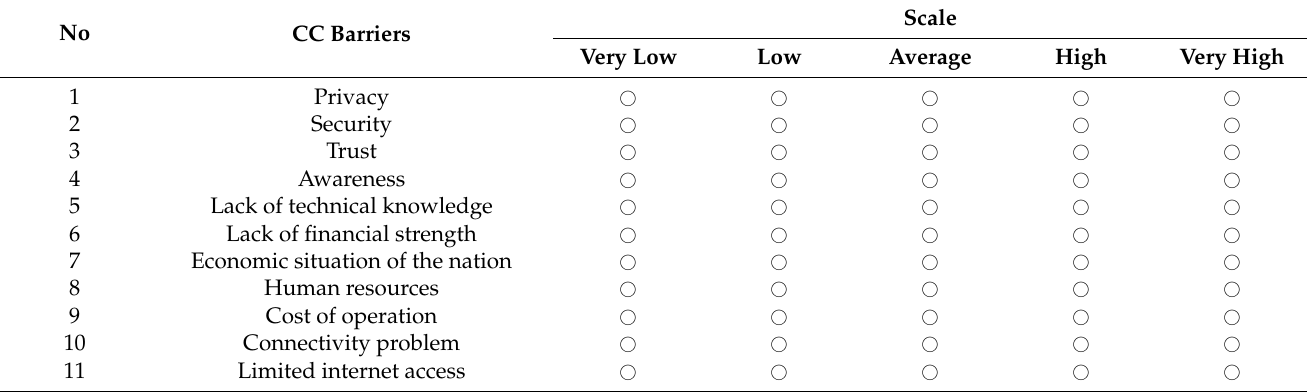
Table A1. The survey questions regarding the barriers to using CC in sustainable